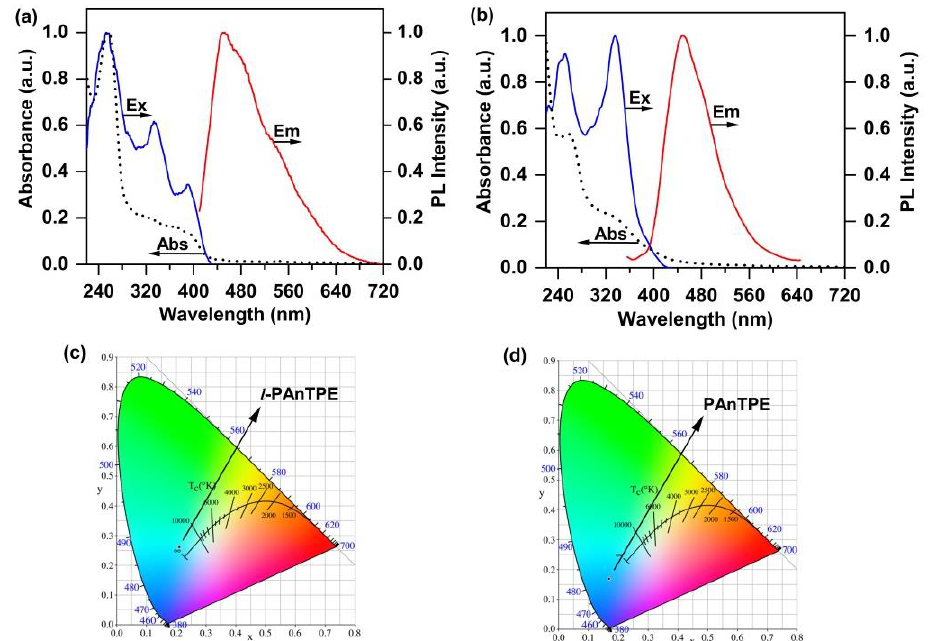
Figure 4. The excitation spectra, UV–Vis absorption spectra and emission spectra of l -PAnTPE ( a ) and PAnTPE ( b ) in water. CIE of l -PAnTPE ( c ) and PAnTPE ( d ) in water.